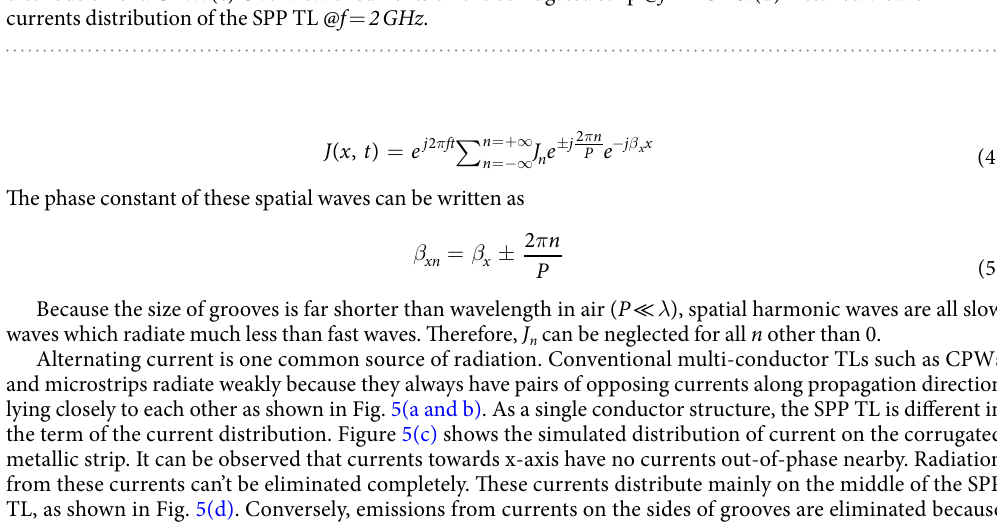
Figure 5. Current distribution on different TLs. ( a ) Current distribution of a microstrip. ( b ) Current distribution of a CPW. ( c ) Overview of currents on the corrugated strip @f = 2 GHz . ( d ) Detailed view on currents distribution of the SPP TL @f = 2 GHz